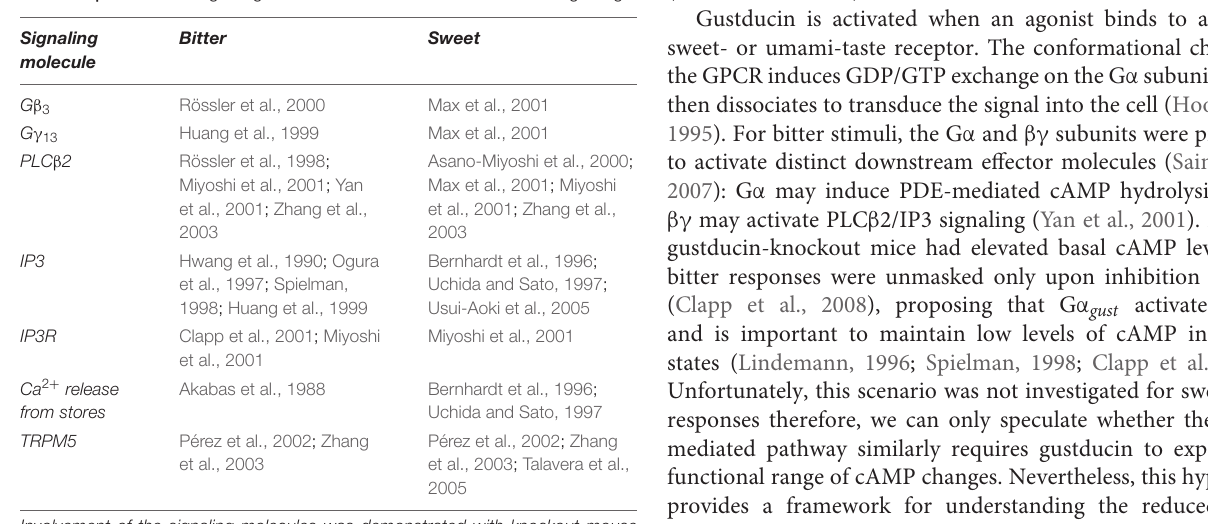
TABLE 2 | Overview of signaling molecules involved in bitter and sweet